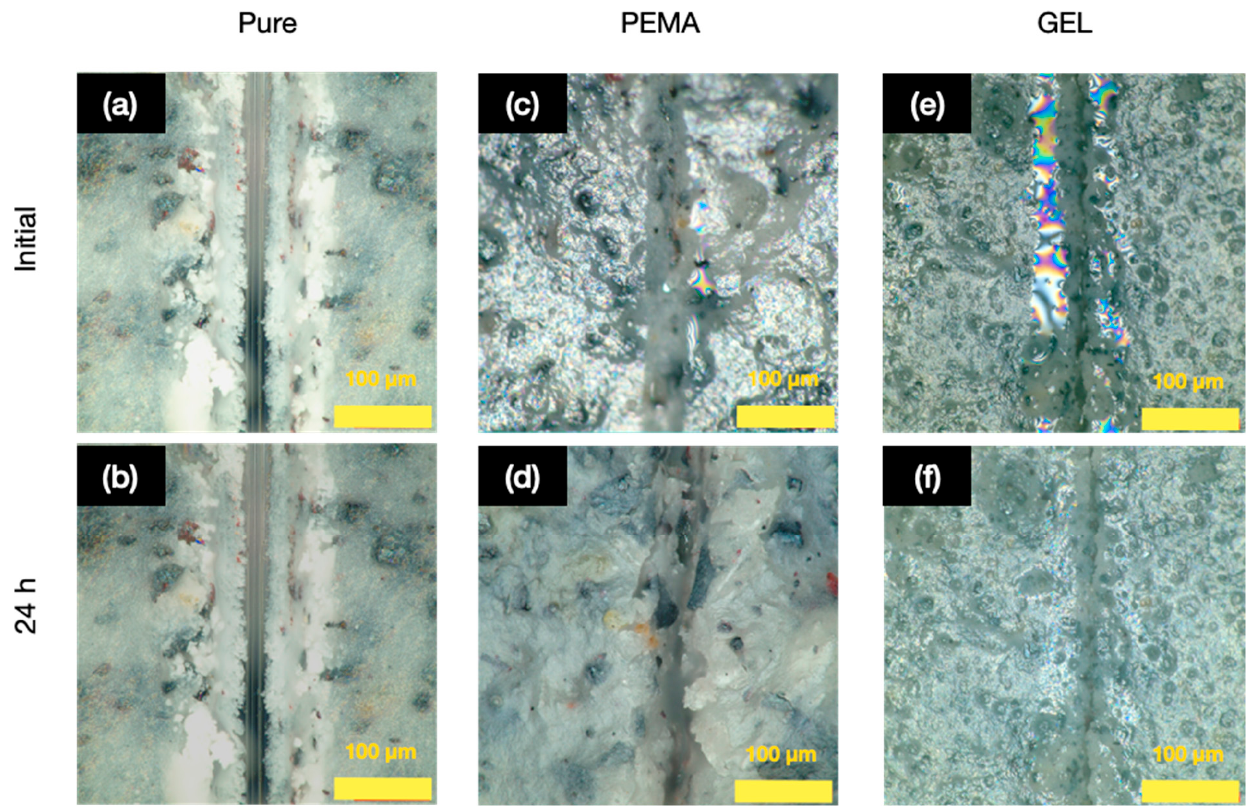
Figure 11. ( a ) Initial scratch for the pure epoxy primer, ( b ) 24 h after scratching the pure epoxy primer, ( c ) initial scratch for the 5 wt. % PEMA embedded epoxy primer, ( d ) 24 h after scratching the 5 wt. % PEMA embedded epoxy primer, ( e ) initial scratch for the 5 wt. % GEL embedded primer, ( f ) 24 h after scratching the the 5 wt. % GEL embedded primer.